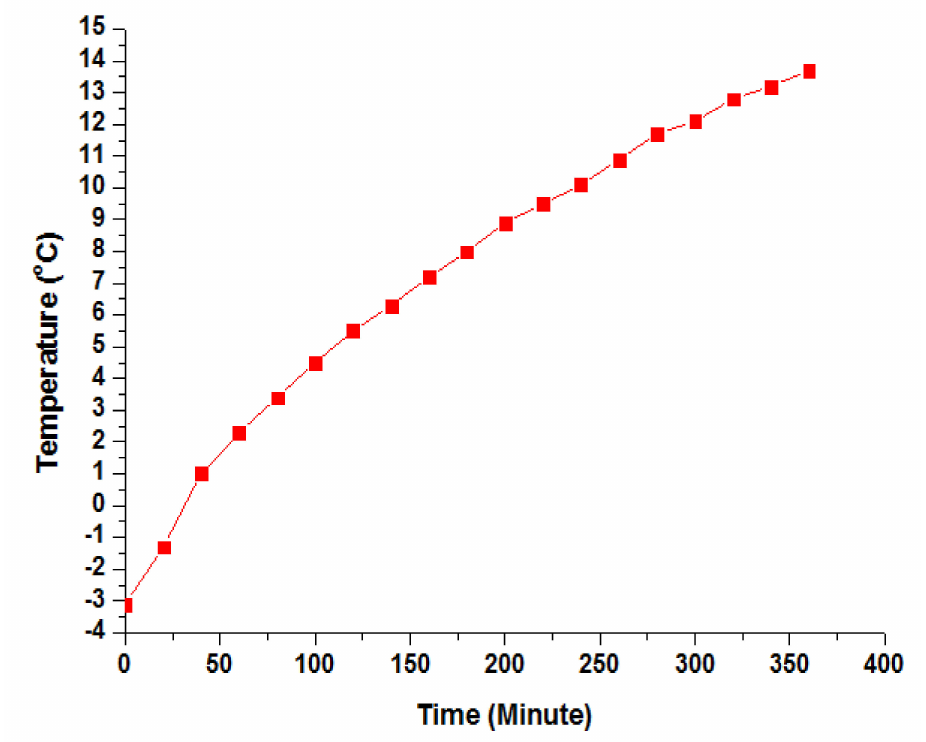
Figure 12. Changes in cold storage material temperature during discharging